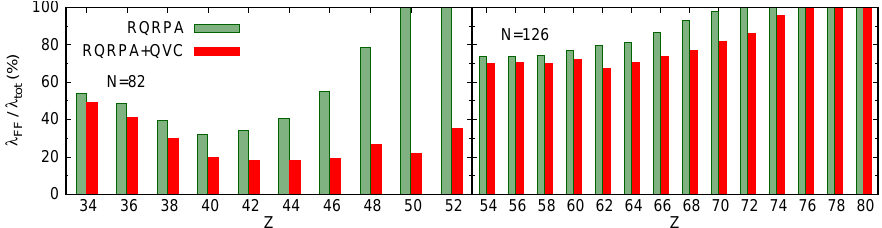
Figure 2. Contributions of FF transitions to the total β -decay rate of N = 82 (left) and N = 126 (right) nuclei, obtained within RQRPA (green boxes) and RQRPA + QVC (red